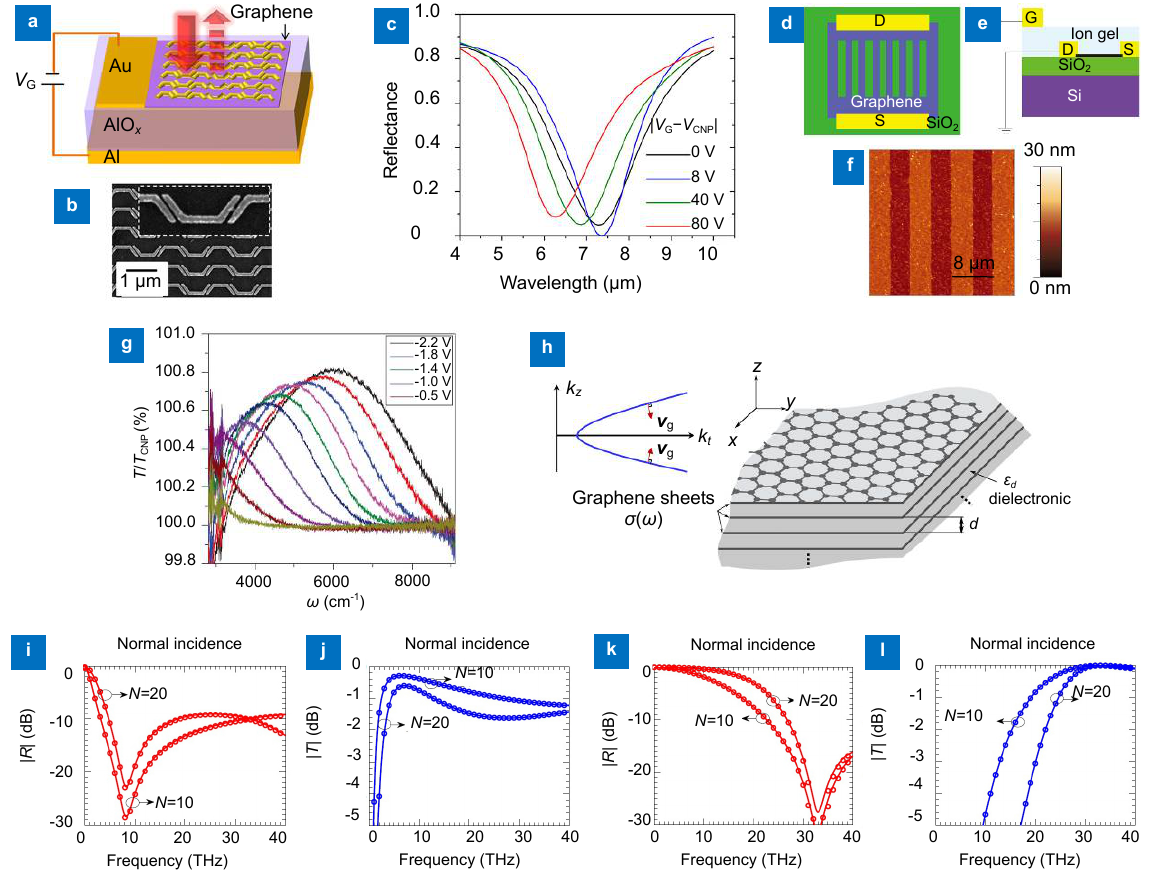
Fig. 9 | Tunable metamaterials using graphene as the active material. ( a ) Schematic view of the ultrathin optical modulator based on a tunable metasurface absorber. ( b ) SEM image of the metasurface on graphene (a zoomed-in view of a portion of the metasurface is shown in the inset). ( c ) Normalized measured reflection spectra of the metasurface absorber for different gate voltages ( V G − V CNP = V CNP is the gate voltage when the concentrations of electrons and holes in the graphene sheet are equal) to the reflection spectra from a 300 nm Al film on the same silicon substrate. Schematic ( d ) top and ( e ) side view of a typical graphene micro-ribbon array on a Si/SiO 2 substrate, ( f ) AFM image of a graphene micro-ribbon array sample with a ribbon width of 4 mm and a ribbon and gap width ratio of 1:1, and ( g ) relative mid-infrared transmission spectra ( T / T CNP ) of the graphene ribbon array as gate voltage ( V g − V CNP ) varies from -0.3 to 2.2 V (the voltages corresponding to the un-labeled lines, starting with the red line and alternating downwards, are 2.0 V, 1.6 V, 1.2 V, 0.7 V and 0.3 V). ( h ) Schematic view of the composite multilayer material made by stacking graphene sheets and dielectric layers (under certain conditions, it exhibits hyperbolic-like iso-frequency wavevector dispersion which is shown in the inset, where V g indicates the direction of the group velocity), ( i ) reflection and ( j ) transmission for a finite thickness graphene-silica multilayered HM, at normal polarization, calculated by transfer matrix method (solid lines) and EMA (circles) when graphene layers are unbiased, i.e., μ c = 0 eV, and ( k ) reflection and ( l ) transmission versus frequency, for the same set of parameters, except that now graphene layers are biased with μ c = 0.4 eV. Figure reproduced from: ( a – c ) ref. 88 , American Chemical Society; ( d – g ) ref. 49 , Springer Nature; ( i – l ) ref. 162 , Optical Society of